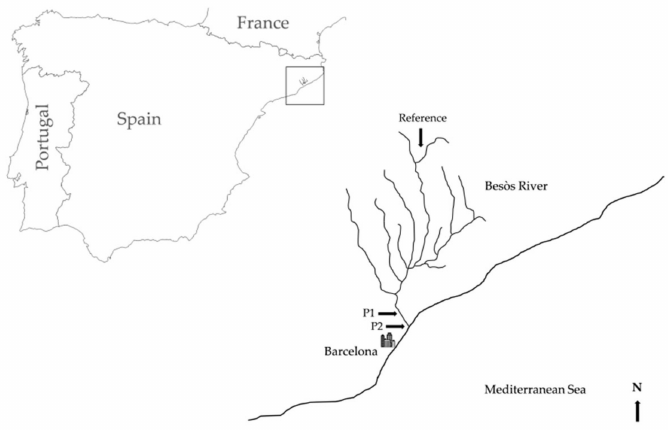
Figure 1. Map showing the location of the three sites sampled in the present study (Reference, P1 and P2) within the Bes ò s River, in north-east